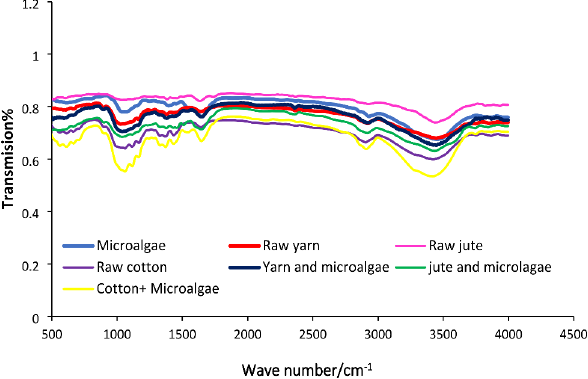
Fig. 8 Carbohydrate content of suspended and attached systems on different carriers (jute, cotton, and positive charge yarn) (Value shown as mean ± SD).